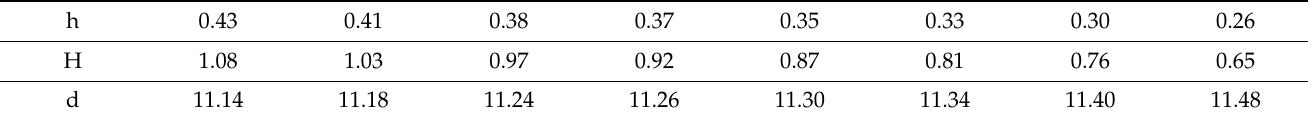
Figure 1. Experimental apparatus for forming process. 4—Extrusion tap; 1—Worktable; 2—Special fixture; 5—Temperature sensor; 3—Coil; 7—Induction; heater; 6—Thermometer; 8—Cooling water pipe. Table 2. Relationship between tooth profile height H and indentation depth h.